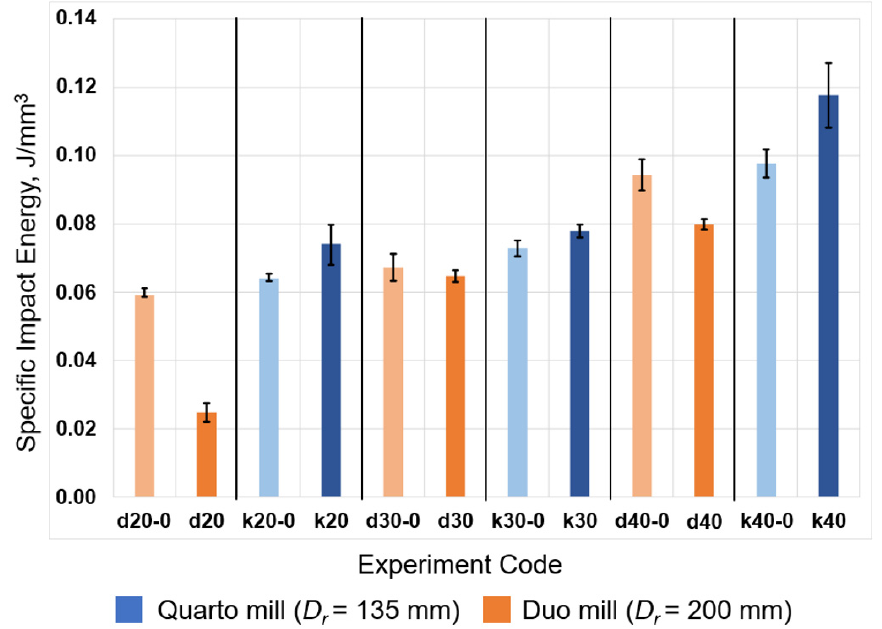
Figure 6. The specific impact energy absorbed by both non-reinforced and reinforced composites roll bonded with nominal reductions of 20%, 30%, and 40% using two types of rolling mills. Letters “d” and “k” mean the type of the rolling mill: “d” is duo (diameter of rolls: 200 mm) and “k” is quarto (diameter of rolls: 135 mm); numbers 20, 30 and 40 point to the nominal rolling reduction; “0” is the marker for non-reinforced composites.